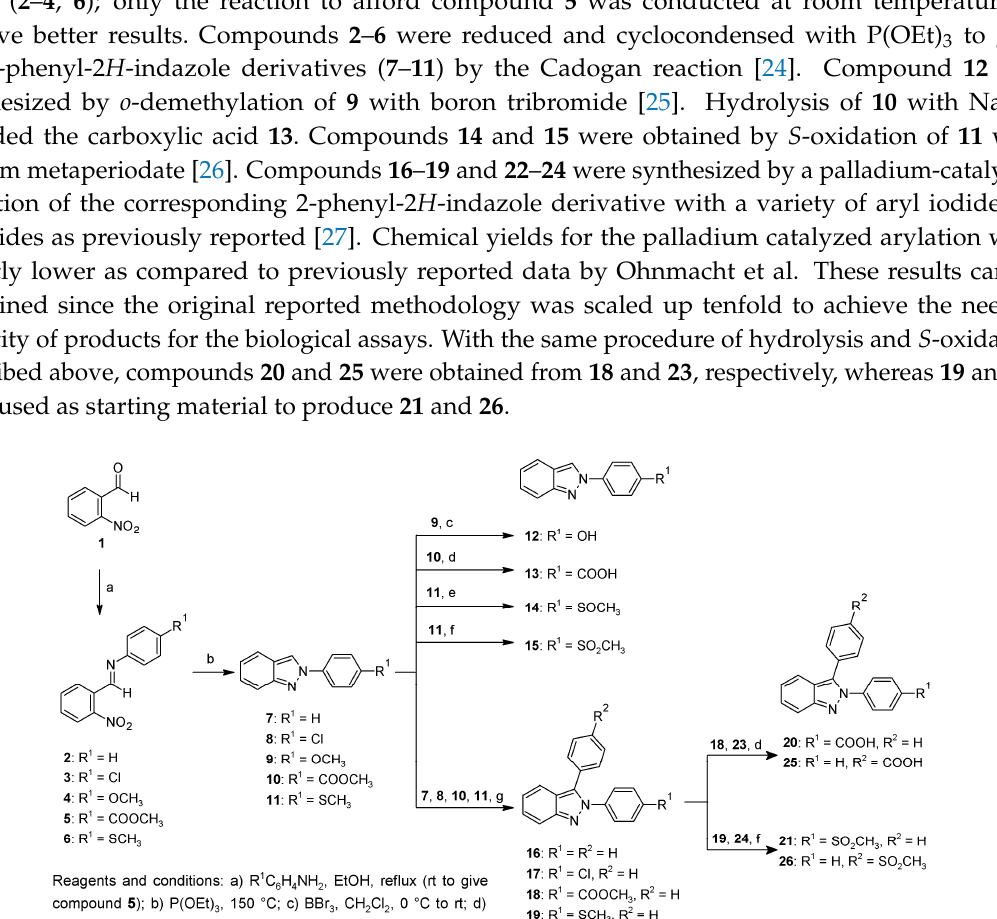
Figure 1. Design of the 2,3-diphenyl-2 H -indazole